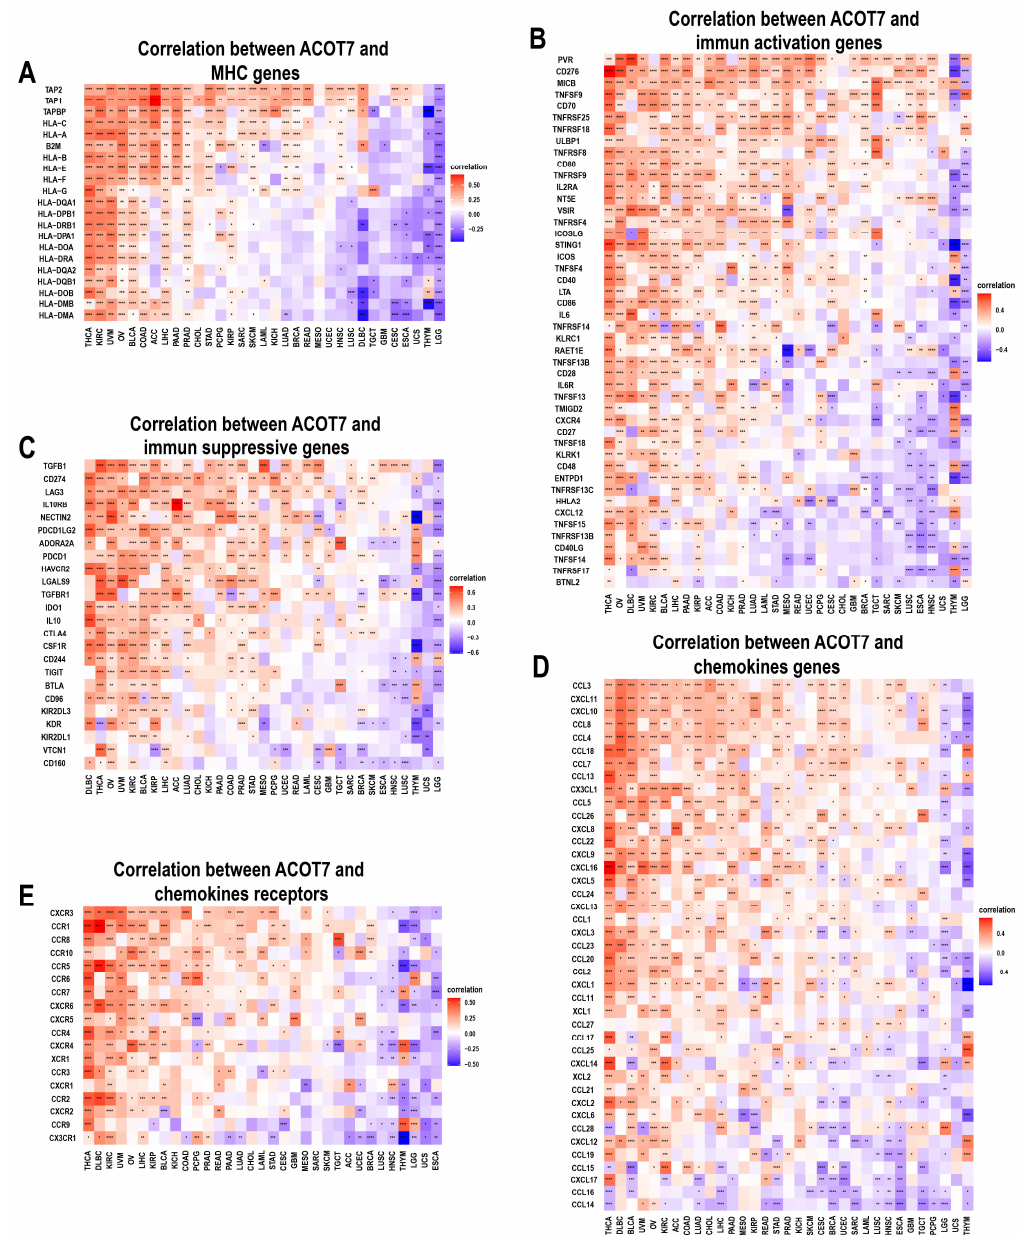
Figure 8. Heatmaps of ACOT7 and immune-related gene co-expression. ( A ) Major histocompatibility complex (MHC) genes, ( B ) immune activation genes, ( C ) immune suppressive genes, ( D ) chemokine genes, ( E ) chemokine receptor genes. * p < 0.05, ** p < 0.01, *** p < 0.001 **** p < 0.0001. TMB and MSI are considered as indicators of immunotherapy response and